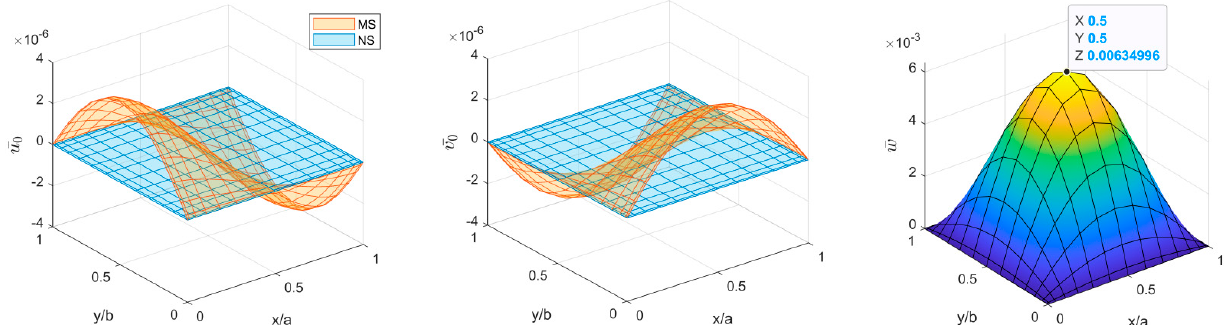
Figure 5. Identical solutions generated by both MS and NS formulations. In-plane displacements 𝑢 (cid:2868)(cid:3015)(cid:3020) , 𝑣 (cid:2868)(cid:3015)(cid:3020) (blue surfaces) and 𝑢 (cid:2868)(cid:3014)(cid:3020) ,𝑣 (cid:2868)(cid:3014)(cid:3020) (orange surfaces) for a fully clamped square plate (𝑎/ℎ = 100,𝑛 (cid:3053) = 0.5,𝑛 (cid:3051) = 0) . Figure 6. Identical solutions generated by both MS and NS formulations for a movable simply supported square plate (𝑎/ℎ = 100, 𝑛 (cid:3053) = 0.5) . In-plane displacements 𝑢 (cid:2868)(cid:3015)(cid:3020) ,𝑣 (cid:2868)(cid:3015)(cid:3020) (blue surfaces) and 𝑢 (cid:2868)(cid:3014)(cid:3020) , 𝑣 (cid:2868)(cid:3014)(cid:3020) (orange surfaces).